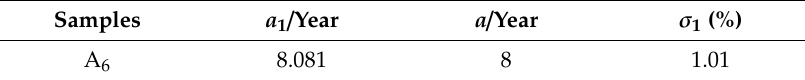
Table 8. Predicted and actual aging time of composite